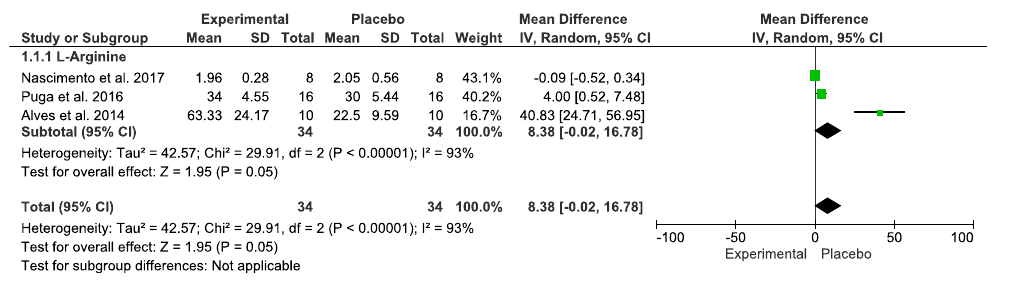
Figure 5. Effects of L-Arginine on inflammatory markers.